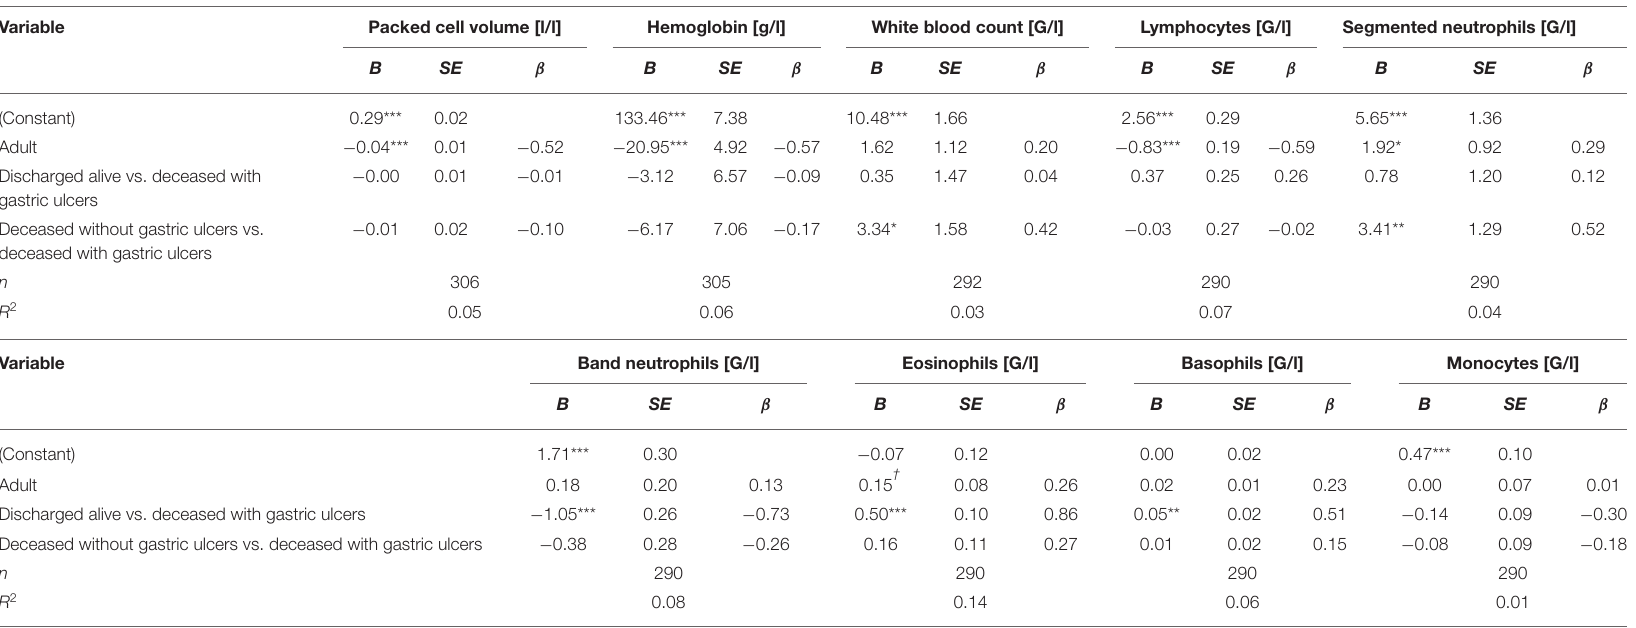
TABLE 6 | Multiple linear regression estimation for blood values. Variable Packed cell volume [l/l]